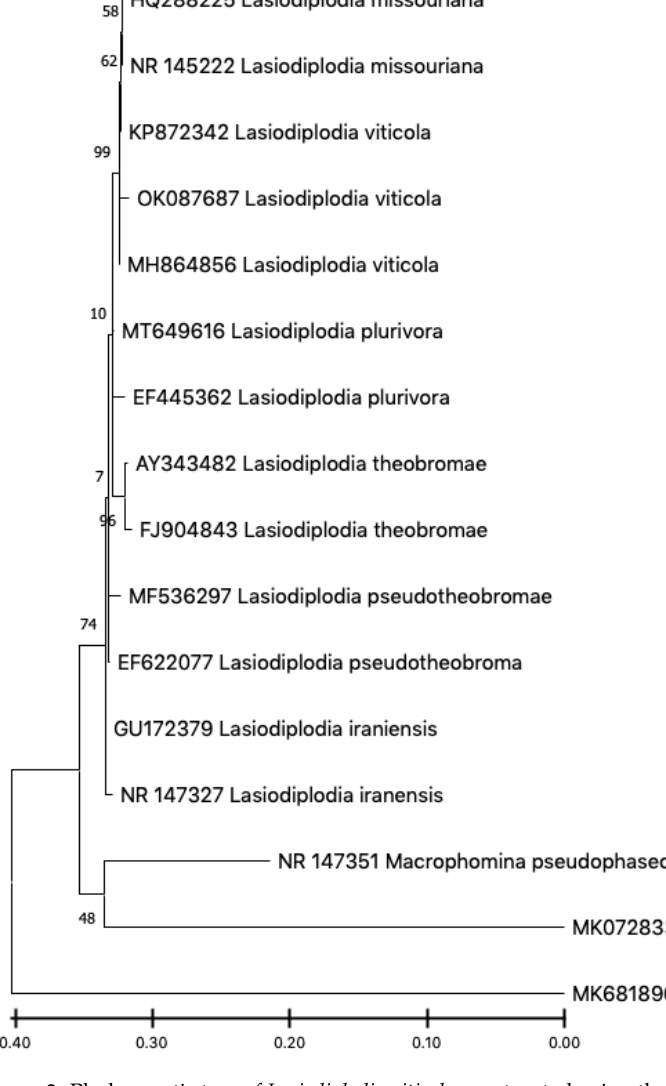
Figure 3. Phylogenetic tree of Lasiodiplodia viticola constructed using the maximum likelihood method with 1000 bootstrap values, based on their internal transcribed spacers (ITS), β -tubulin and calmodulin (cmdA) sequences, showing the position of our fungus clustered with its reference.